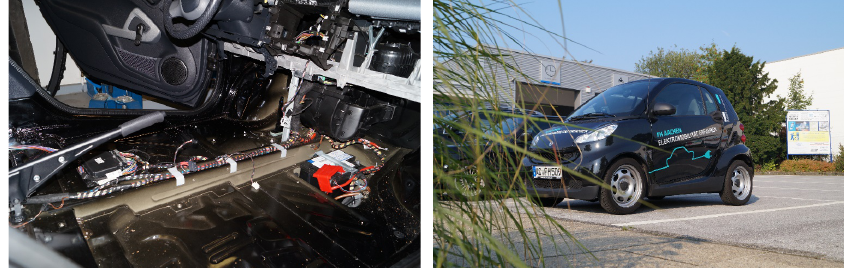
Fig. 6. Conversion of the Smart to an E-Smart: new harness (left) and E-Smart after official approval